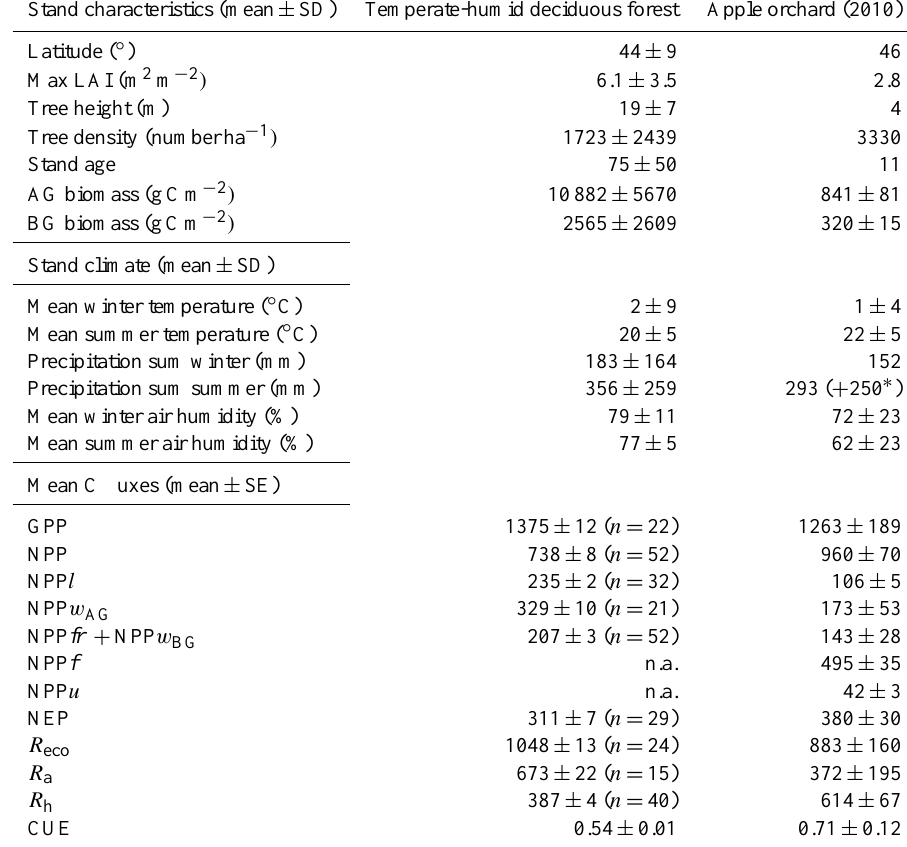
Table 8. Table of comparison between natural woody ecosystems of temperate-humid biomes (dataset of Luyssaert et al., 2007) and the studied apple orchard, a woody